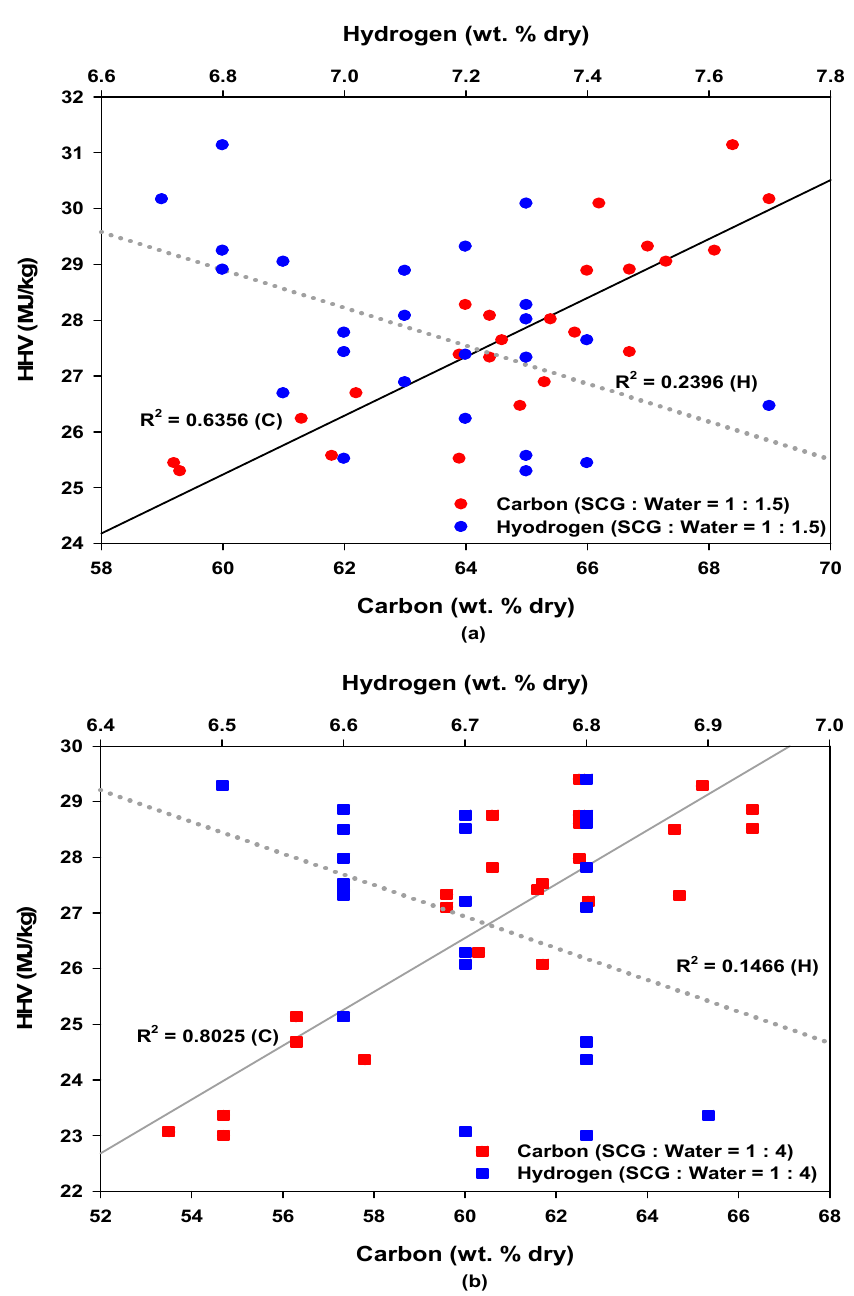
Figure 8. Van Krevelen diagram of raw material, coal, and hydrothermally carbonized SCGs pro- duced with different reaction temperatures and water contents.